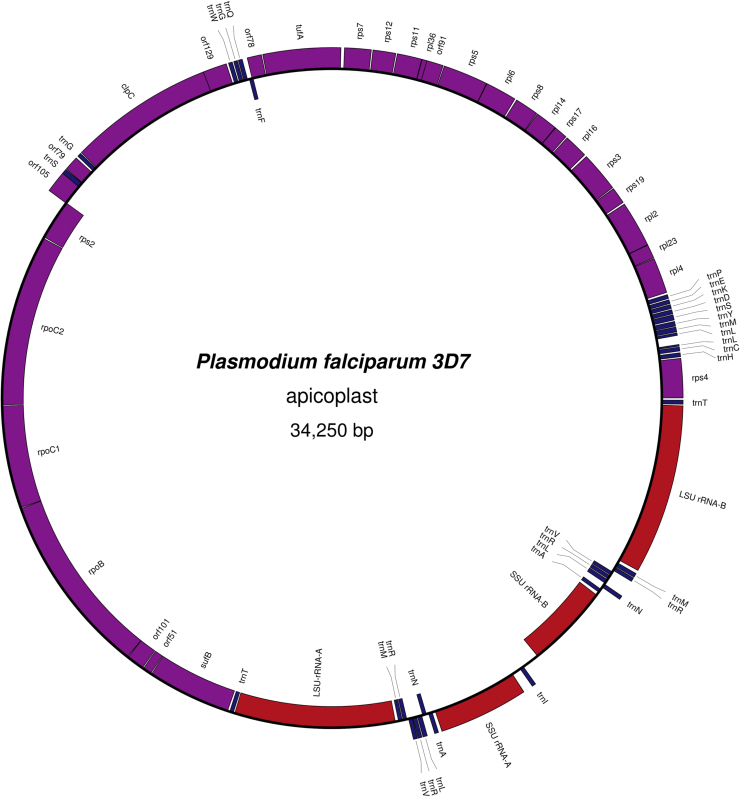
Plasmodium falciparum apicoplast genome. Purple indicates protein-coding genes, blue indicates tRNA genes and red indicates rRNA genes. Genome drawn using OrganellarGenomeDRAW (Lohse et al. 2013).